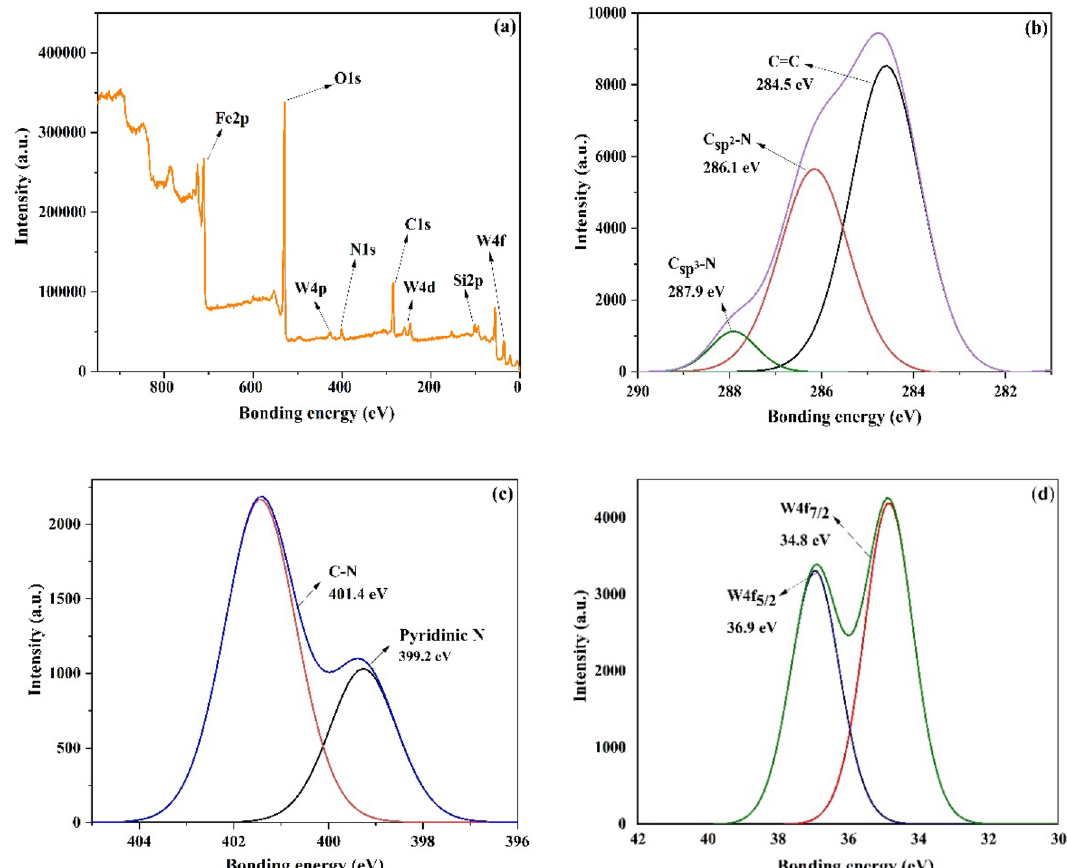
Figure 3. XPS spectra of ( a ) (γ-Fe 2 O 3 -Im-Py) 2 WO 4 , ( b ) C1s, ( c ) N1s and ( d )